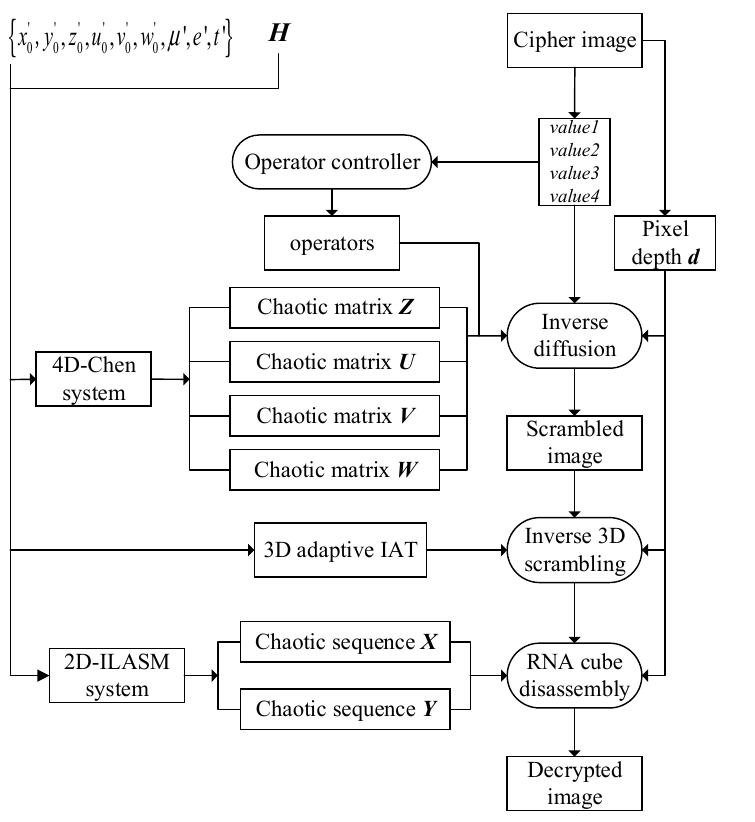
Figure 9. The decryption flowchart of the proposed algorithm.